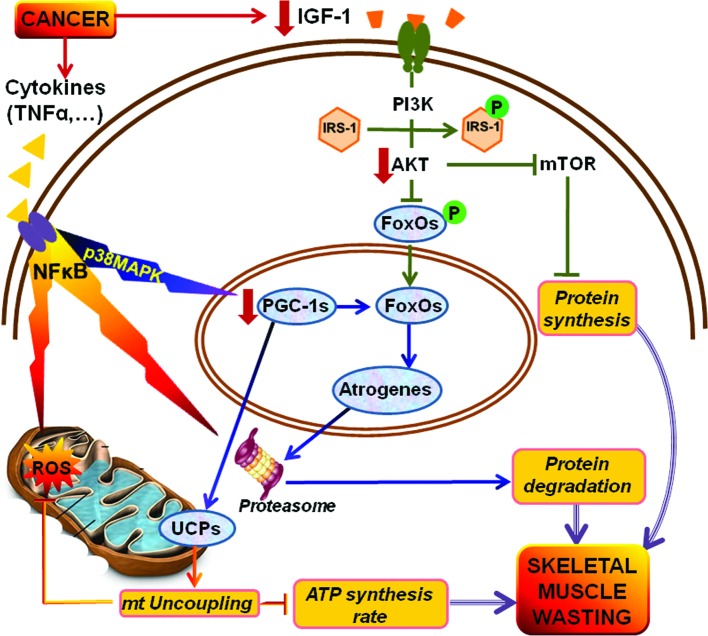
Putative PGC-1-mediated mechanism of cancer-induced skeletal muscle wasting. In this model, significant down-regulation of PGC-1ß expression causes dysregulation of mitochondria, resulting in reduced ATP synthesis and increased ROS production, most likely due to PGC-1-dependent upregulation of UCPs. Meanwhile, reduced PGC-1ß gene expression levels result in a failure to down-regulate expression of FoXO3α, which normally suppresses atrogen expression and proteolysis. Insulin-stimulated IGF-1/AKT pathway signaling is also significantly attenuated. Thus, AKT does not phosphorylate FoXOs and, consequently, favors further upregulation of atrogenes, thus leading to skeletal muscle wasting. Moreover, reduced IGF-1/AKT signaling further facilitates protein translation inhibition due to mTOR inactivation which also results in cachexia. Meanwhile, PGC-1ß may affect IGF-1 and IRS-1 expression thereby producing insulin resistance in skeletal muscle. IRS-1, insulin receptor substrate 1; IGF-1, insulin-like growth factor 1; PGC-1s, peroxisome proliferator-activated receptor-γ coactivators-1; UCPs, uncoupling proteins; FoXOs, forkhead box O proteins; ROS, reactive oxygen species; TNFα, tumor necrosis factor α; NF-κB, nuclear factor-κB.